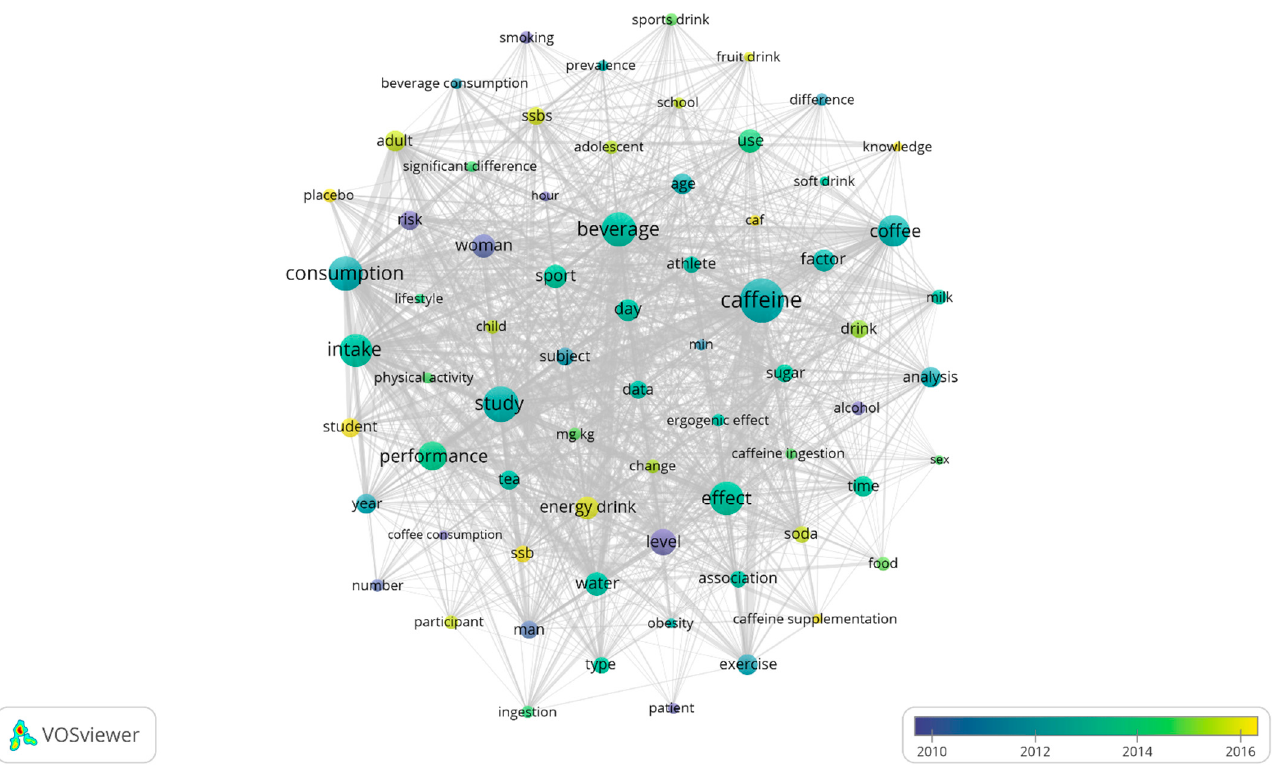
Figure 10. Temporary key terms graph.